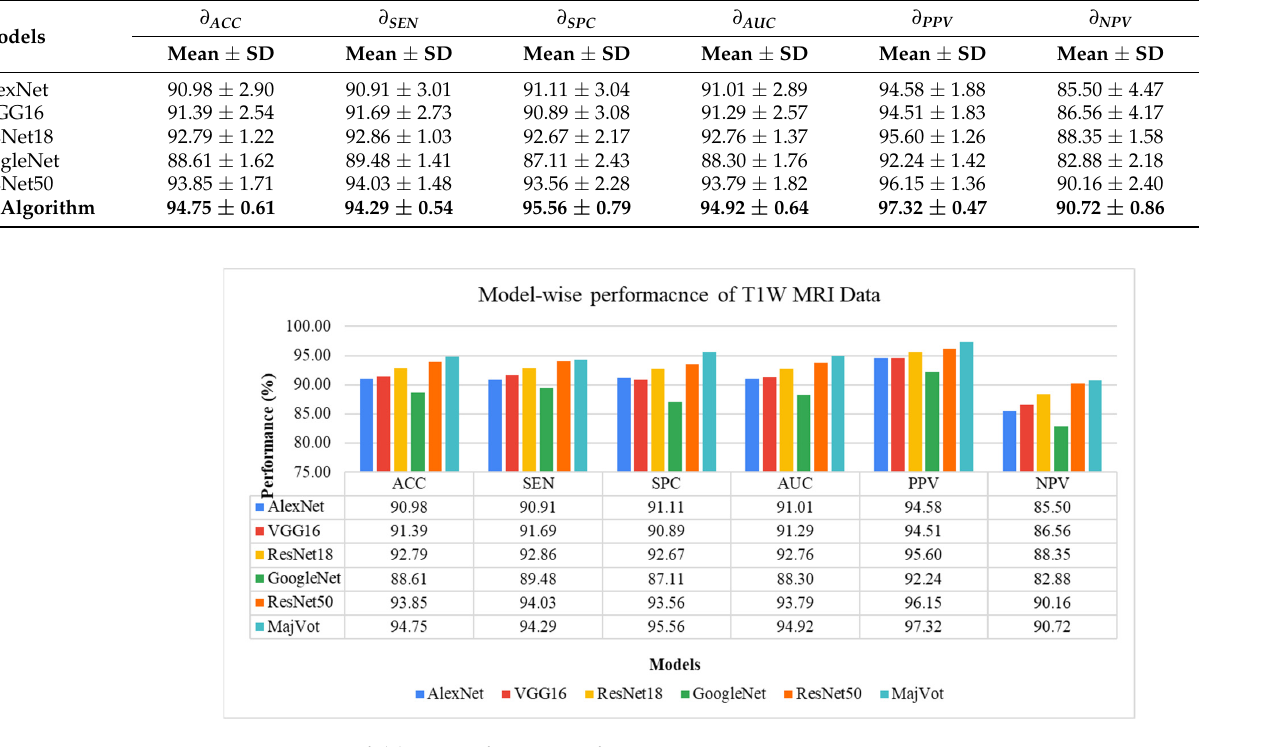
Figure 7. Five-fold test performance of T1W-MRI Data.